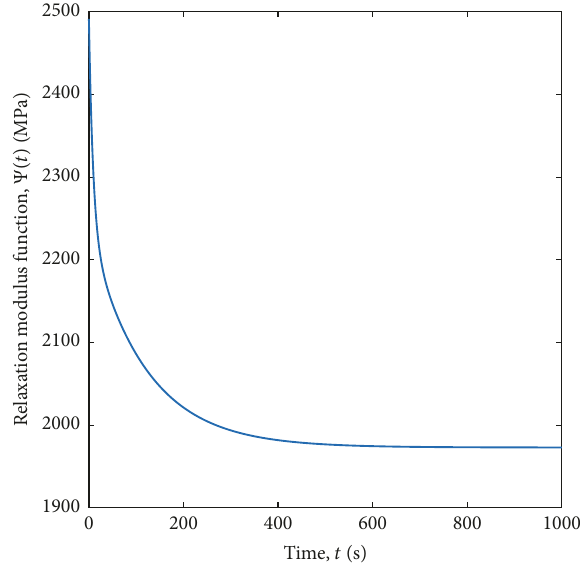
Figure 1: Relaxation modulus function of